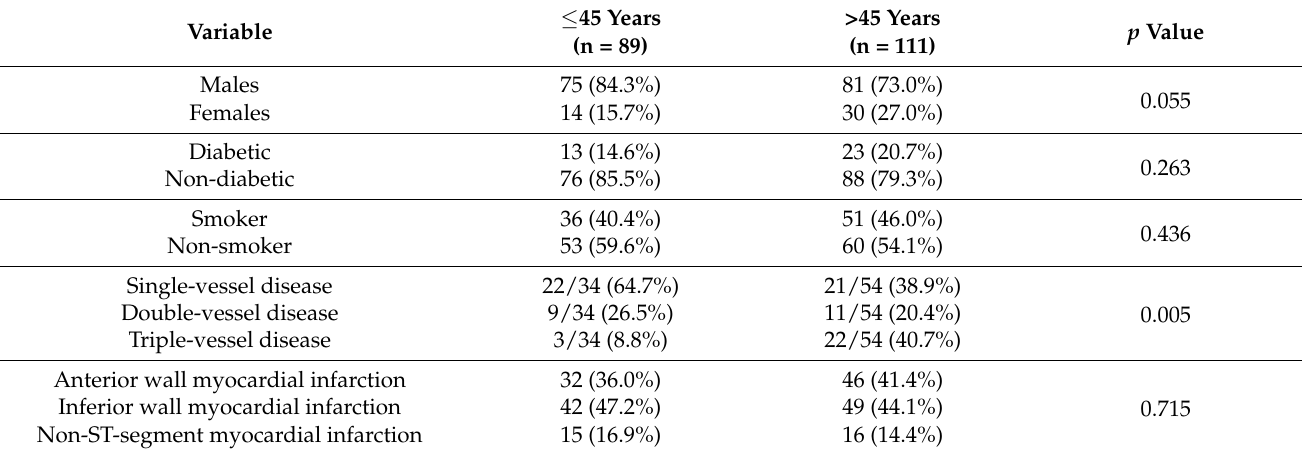
Table 2. Demographics according to